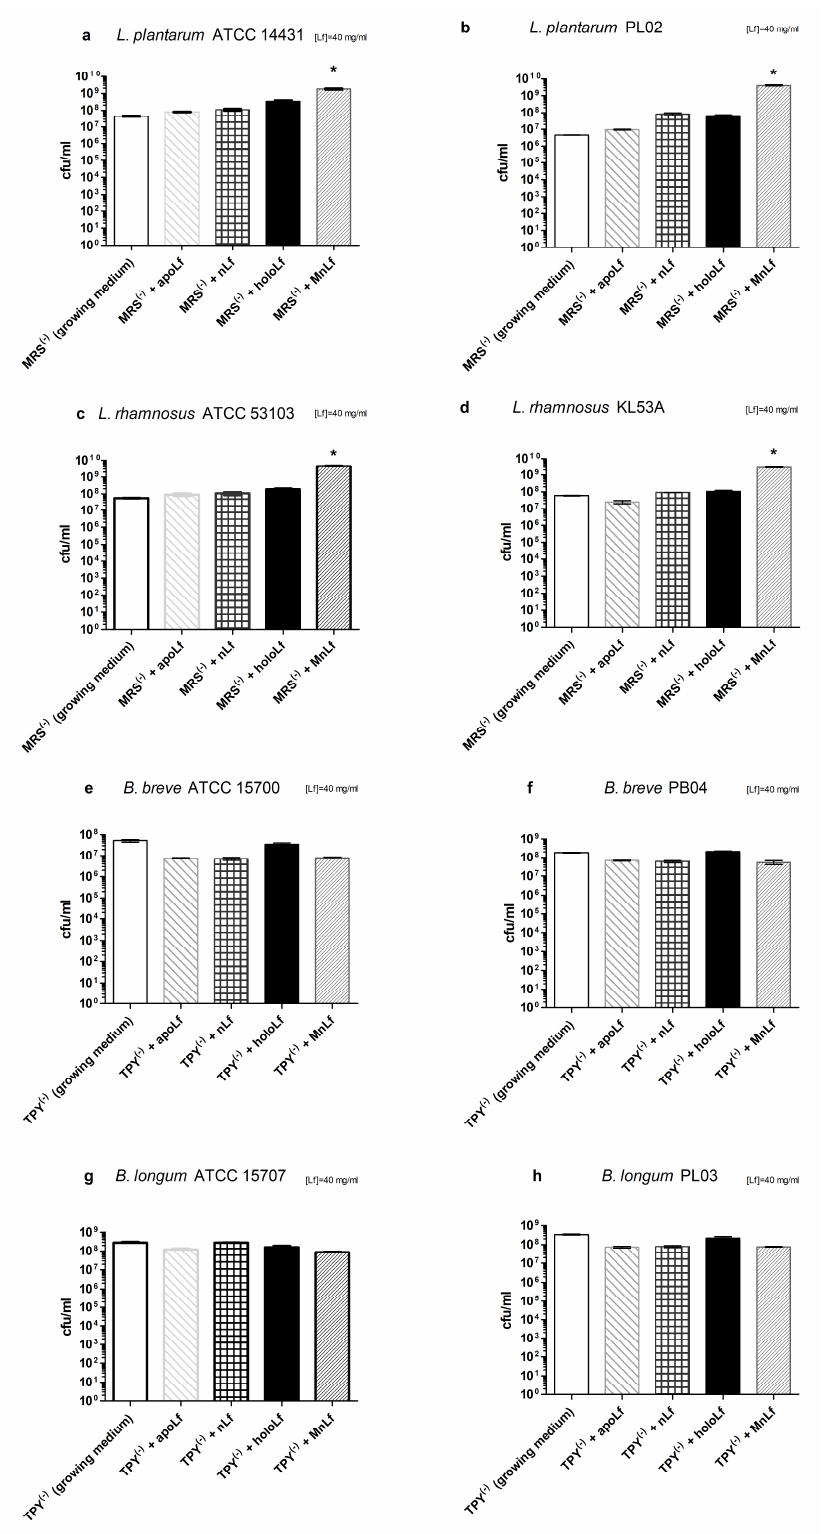
Figure 5. Quantitative assessment of tested strains growth after 24 h incubation with various lactoferrin forms: L. plantarum ATCC 14431 ( a ), L. plantarum PL02 ( b ), L. rhamnosus ATCC 53103 ( c ), L. rhamnosus KL53A ( d ), Bifidobacterium breve ATCC 15700 ( e ), B. breve PB04 ( f ), Bifidobacterium longum ATCC 15707 ( g ), B. longum PL03 ( h ). Statistical significance was evaluated for tested lactoferrin forms in comparison with the growth medium using one-way ANOVA, * p < 0.05. MRS, Man, Rogosa and Sharpe broth; TPY, trypticase-phytone-yeast